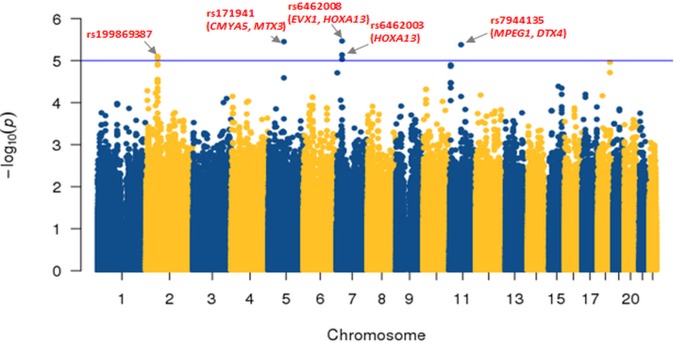
Chromosomal distribution of the single-nucleotide polymorphisms (SNPs) associated with the seroclearance of hepatitis B surface antigen (HBsAg) in patients with chronic hepatitis B (CHB).The Manhattan plot shows the chromosomal distribution of the–log10 (P value) of SNPs. The threshold cutoff for the significant SNPs (P <10−5) is shown with horizontal line.